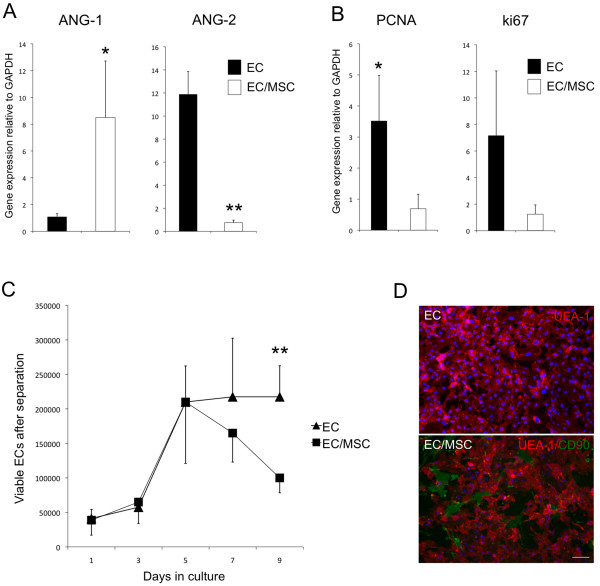
Mesenchymal stem cells induce endothelial cell quiescence. (A) The relative gene expression of ANG-1 and ANG-2 from mono- and co-cultured constructs after one week dynamic culture in vitro was altered by co-seeding endothelial cells (ECs) with mesenchymal stem cells (MSC). An up-regulation of ANG-1 and a down-regulation of ANG-2 was detected. (B) Also, cell proliferation markers PCNA and ki67 were both down-regulated in EC/MSC-constructs. (C) In a two-dimensional co-culture system, which allowed separation of cells, the number of viable ECs was reduced in the presence of MSCs after five days culture. After seven days the difference was not statistically significant (P = 0.07), whereas after nine days the number of viable ECs was significantly reduced in the presence of MSCs. (D) UEA-1 staining (red) demonstrated a quiescent phenotype of ECs in co-culture with CD90-positive MSCs (green) (10x). Nuclei were stained with DAPI. Scale bar = 20 μm. * = P <0.05, ** = P <0.01. ANG-1, angiopoietin-1; ANG-2, angiopoietin-2; DAPI, 4',6-diamidino-2-phenylindole; PCNA, proliferating cell nuclear antigen.